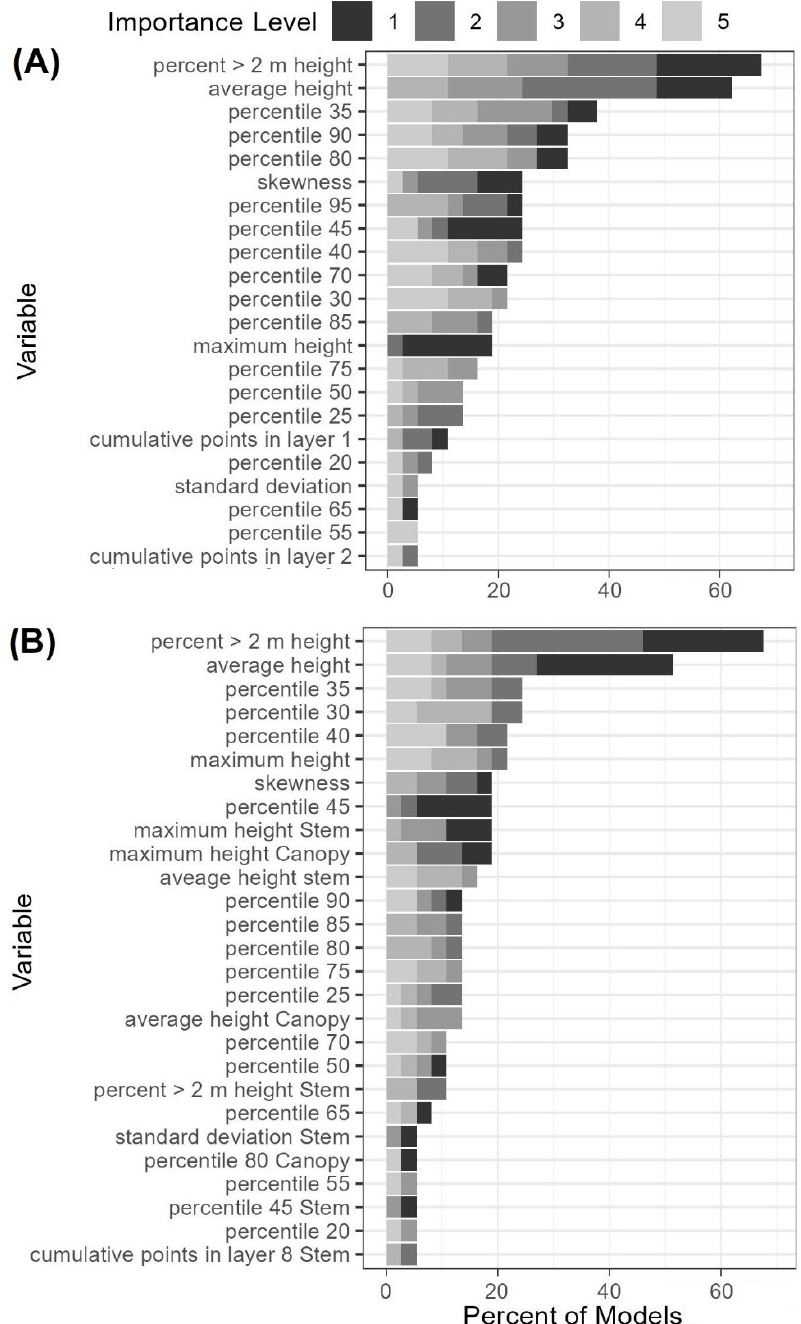
Figure 6. Comparison of the five most important Random Forest variables for the Standard ( A ) and Standard + NGRR ( B ) datasets, values are sorted based on the percentage of the 37 models they appeared in.